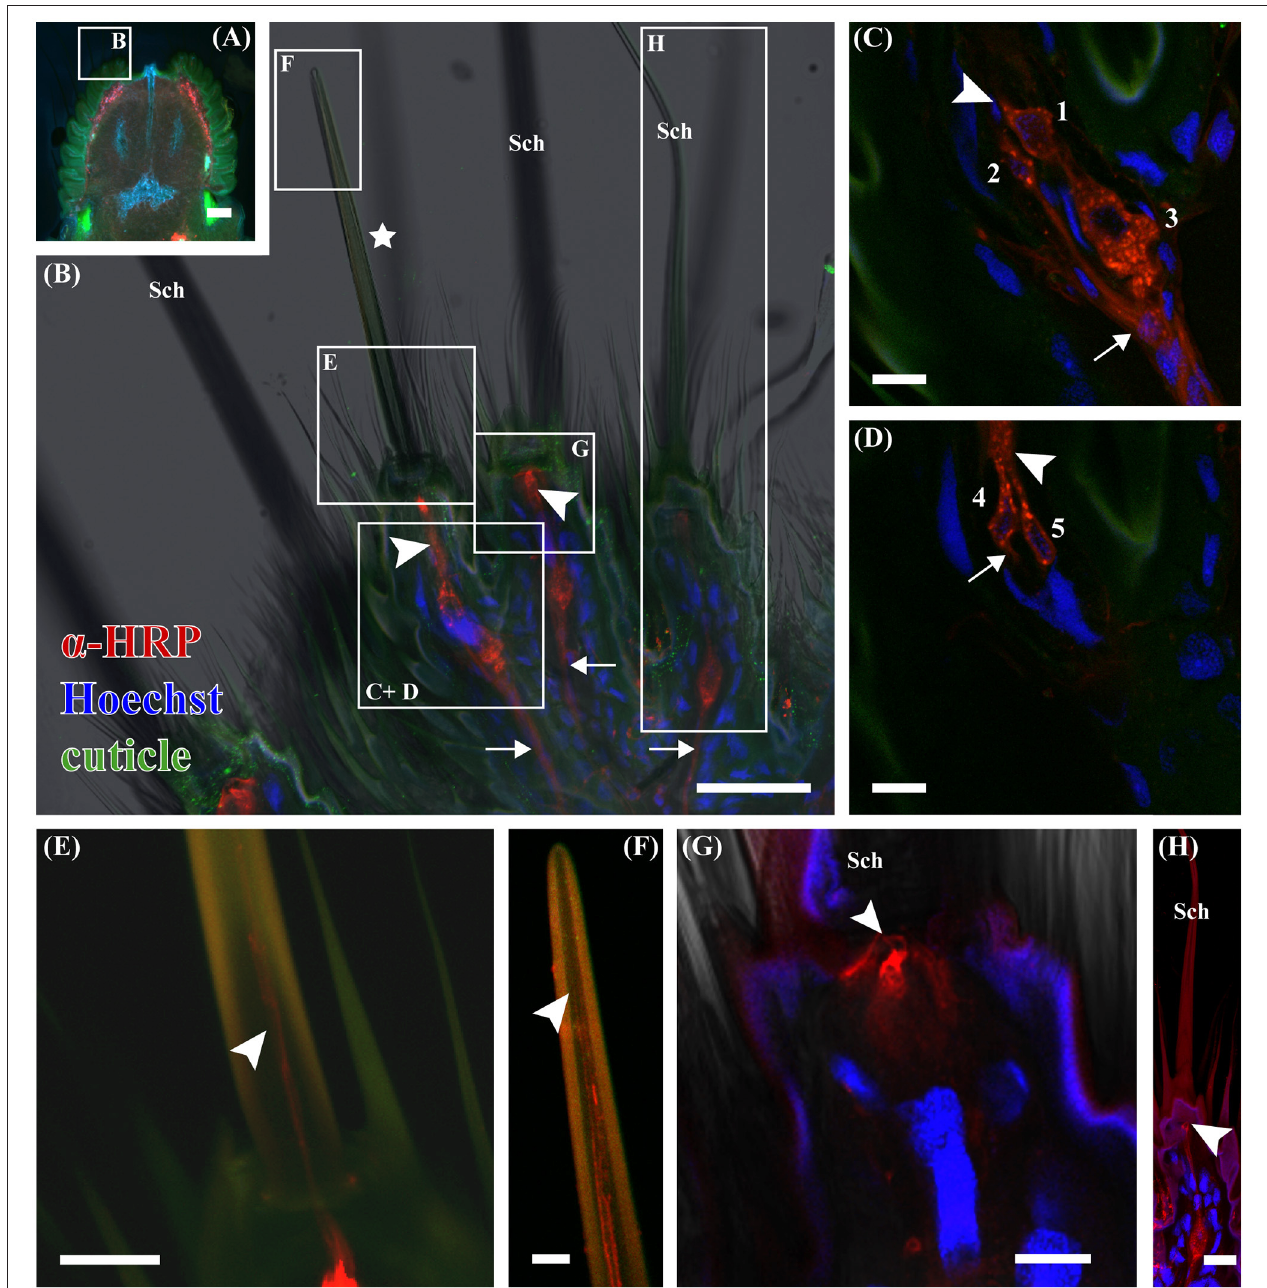
FIGURE 3 | Laser scanning micrographs of a 100 µ m thick horizontal vibratome section of the ovipositor of M. sexta . Neurons were labeled using Cy3-conjugated anti-HRP (red), nuclei using Hoechst 33342 (blue), and the cuticle (green) was visualized using the cuticular autofluorescence. (A) Picture of a 100 µ m thick horizontal vibratome section through a M. sexta ovipositor visualized using a fluorescent stereomicroscope. Cuticular anal papillae, which bears the tubercles with the sensilla have a higher autofluorescence (green) and are on the left and right side of the slide. The ovipore is in the upper part of the image between the two anal papillae. The excerpt shown in (B) is indicated by the white box. (B) Total projection of a confocal laser scanning z-stack, imaging autofluorescence (green), cell nuclei (blue), anti-HRP-immunoreactivity (red), and transmitted light. It shows a part of an anal papillus bearing sensilla chaetica (Sch) and a putative chemosensory sensillum (asterisk). Anti-HRP-immunoreactive cells have dendritic- (arrowheads) and axon-like extensions (arrows); resembling the morphology of neurons. White boxes and letters in this picture present the place where the following pictures originate. (C) Single confocal plane, focusing on multiple anti-HRP-immunoreactive cells (red) below a putative chemosensory sensillum. Indicated are dendritic- (arrowheads) and axon-like (arrows) extensions of those cells; nuclei were stained with Hoechst (blue). Other stained nuclei belong to support or epidermal cells. (D) A second confocal plane of the same section, showing two additional neurons. Numbers in (C,D) label, the different neurons, which are five for this putative chemosensory sensillum. Indicated are dendritic- (arrowheads) and axon-like (arrows) extensions. (E) Single confocal plane showing some dendritic extensions, which can be followed up into the sensillum shaft (arrowhead), however they